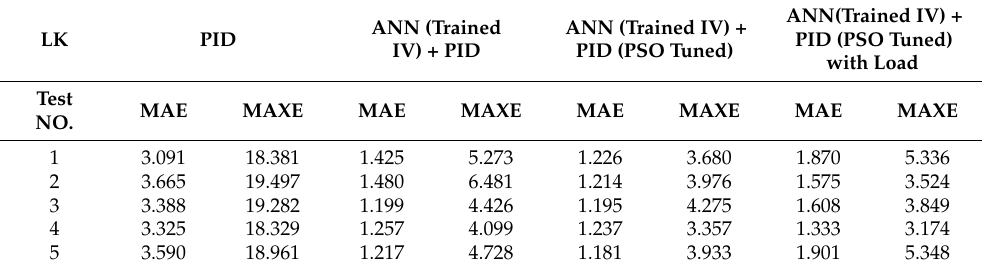
Table 5. Comparison table of tracking outcomes of different controller (left knee). LK PID